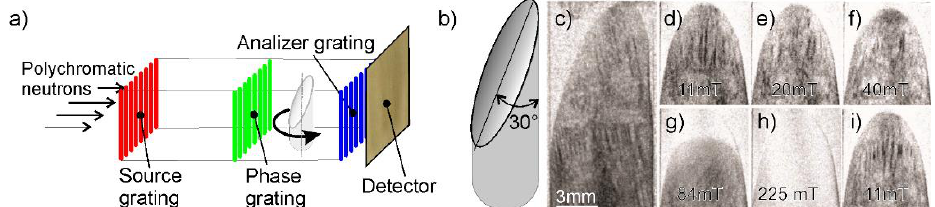
Figure 17. ( a ) representative scheme of the Talbot Lau neutron tomography setup; ( b ) representation of the investigated wedge-shaped FeSi single crystal, radiographic projection images as obtained by Talbot-Lau neutron dark-field radiography; ( c – i ) the same radiographic projection images obtained under an external magnetic field (parallel to the cylinder axis) of 11 mT, 20 mT, 40 mT, 84 mT, 225 mT, and 11 mT. The dark stripes are caused by domain walls that are nearly parallel to the incident beam. Adapted from [186], published by Nature Publishing Group, 2010.